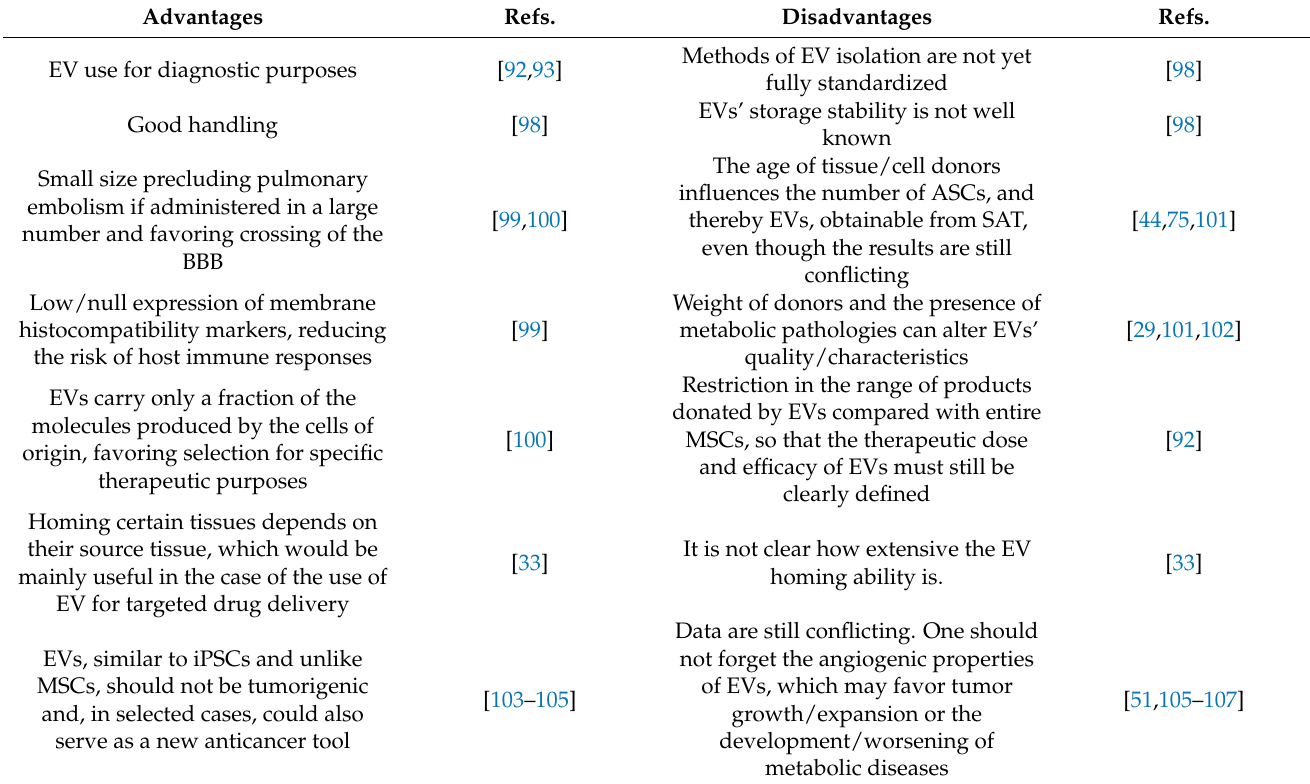
Table 2. Advantages and disadvantages of the use of EVs for future therapeutic/clinical